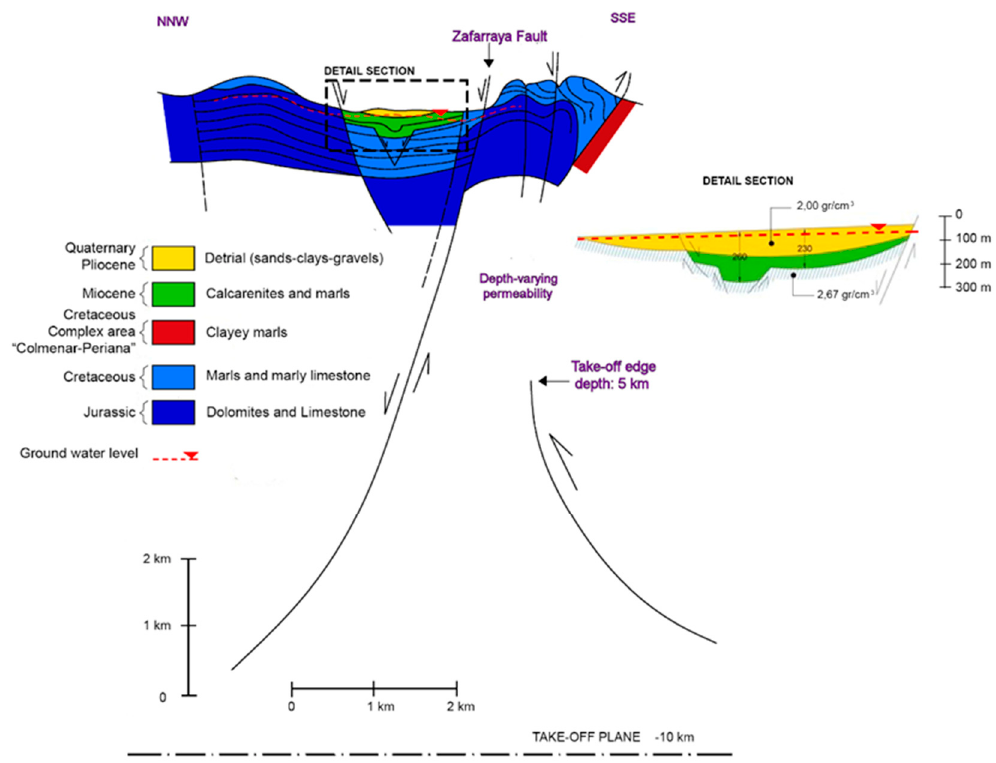
Figure 3. Left: geological section of the Zafarraya fault. Right: Detail section of the near-surface region with the filling of the Zafarraya Polje (adapted from [29]).